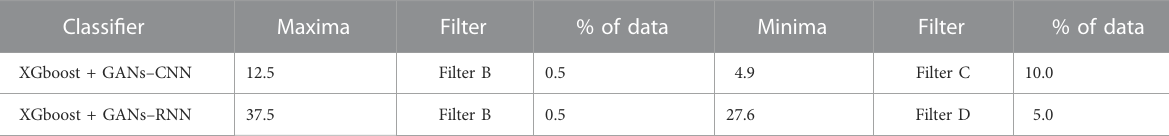
TABLE 7 Enrichment Ratios of OPRD1 on the original dataset with no feature selection with training size of 30%.